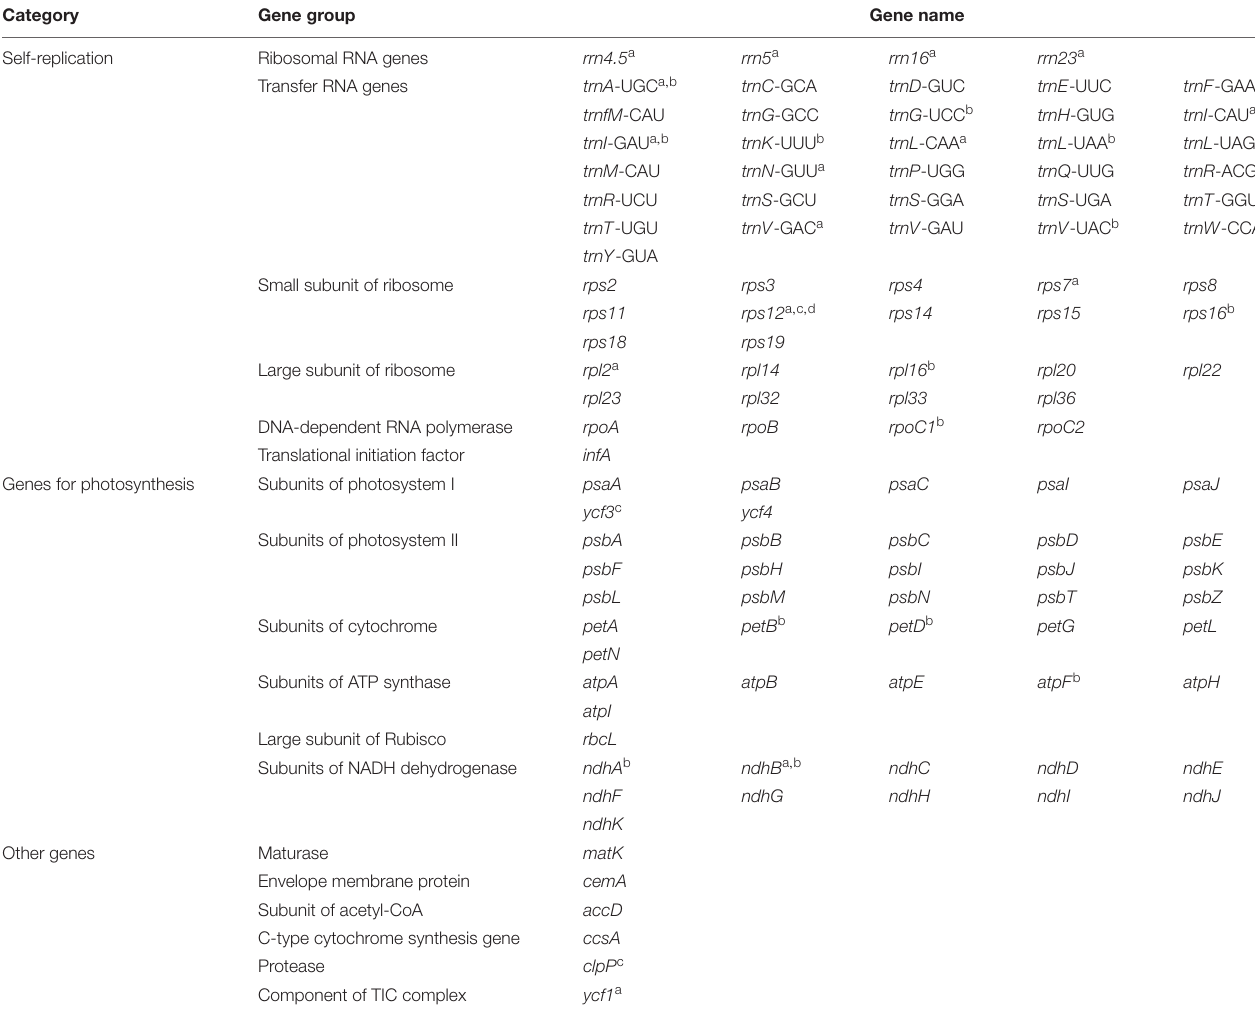
TABLE 2 | List of genes present in Ampelopsis chloroplast genome.